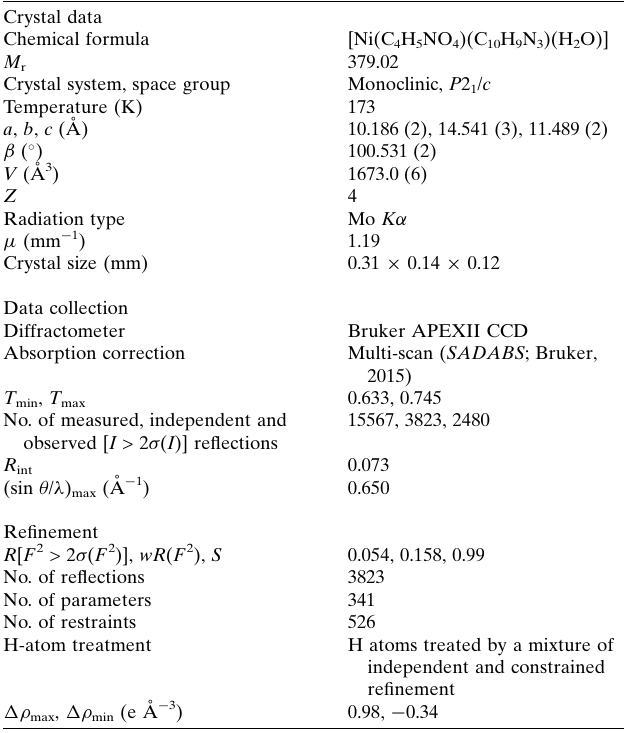
Table 2 Experimental , (cid:4) z + 1 . 2 2